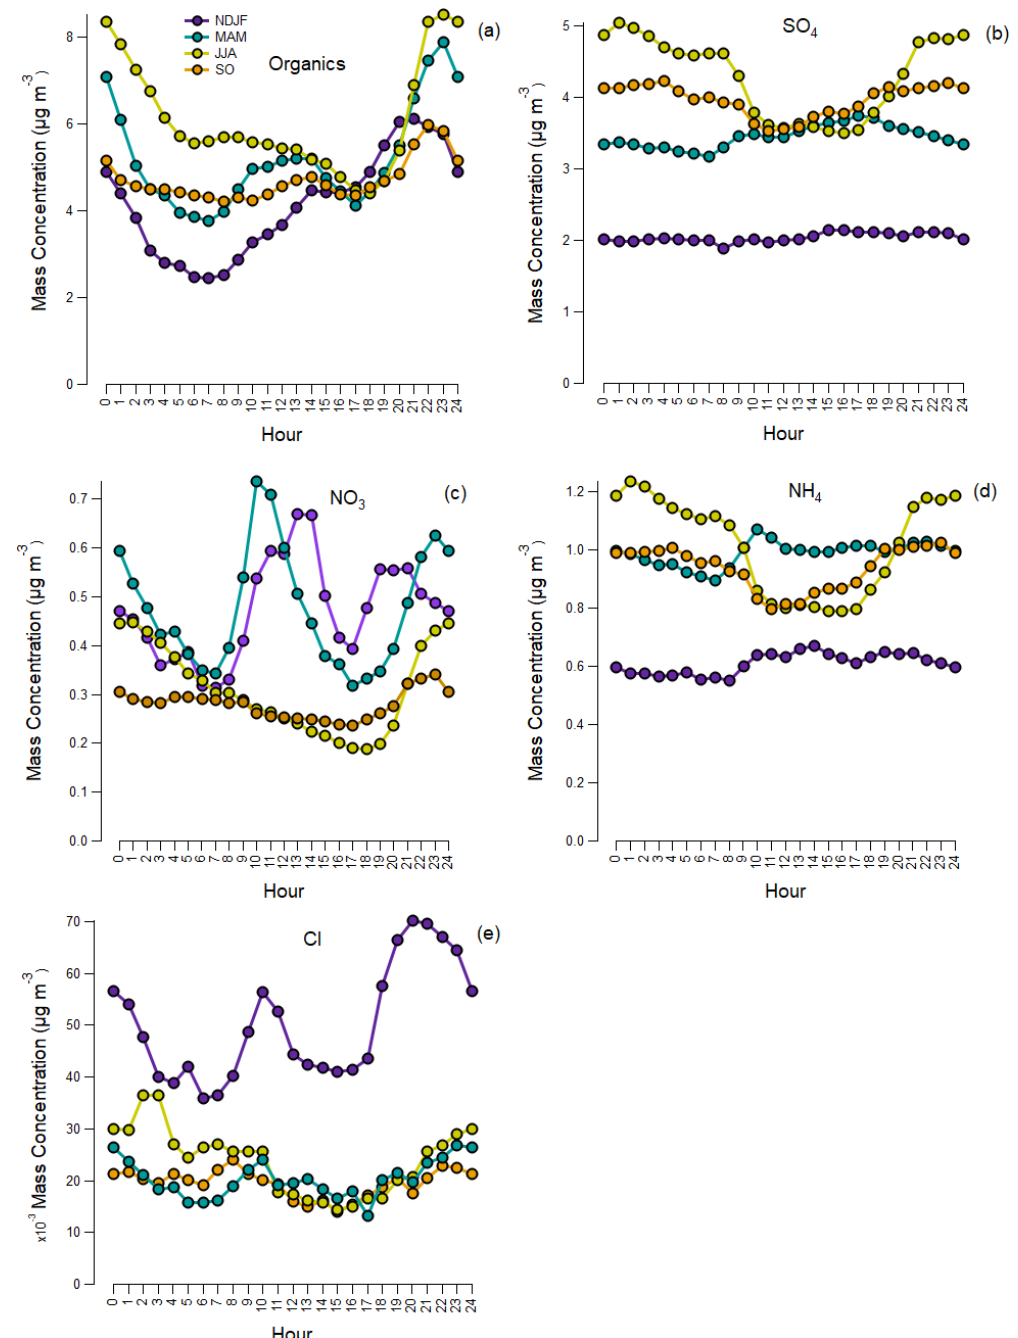
Figure 2. Mean diurnal variation in hourly concentrations of organics (a) , sulfate (b) , nitrate (c) , ammonium (d) and chloride (e) for each period: November–February (NDJF), March–May (MAM), June–August (JJA) and September–October (SO) in local